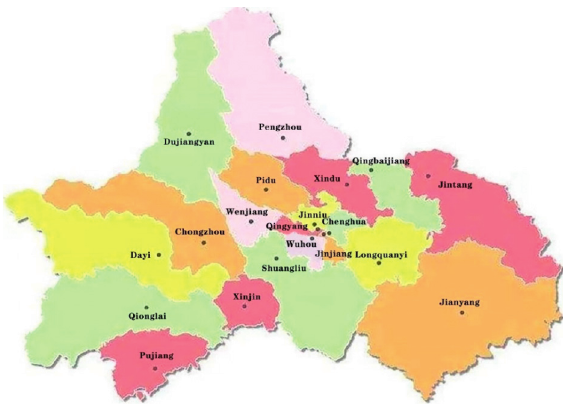
Figure 2: Administrative division map of Chengdu (the 2019 Statistical Yearbook of Chengdu ). Table 4: Mean values of blood demand (unit: